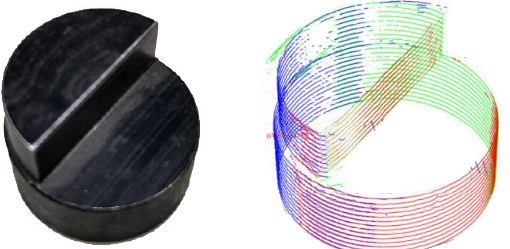
Figure 17: 25 mm diameter cylindrical shaft with undercut – 25 sections with 0.68 mm between sections.